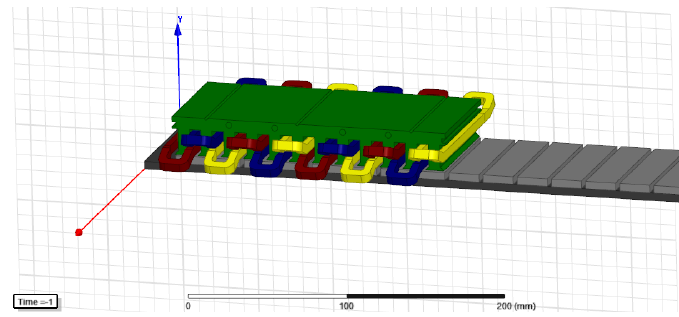
Figure 3. 2D magnetic field density.